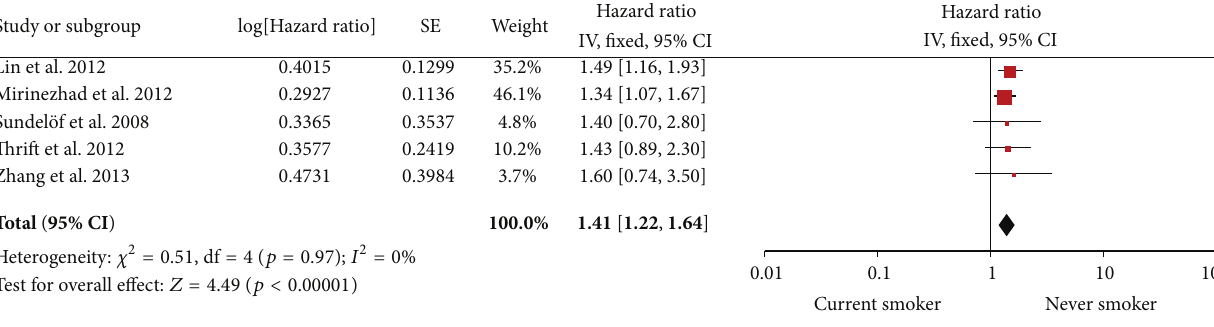
Figure 2: Current smoker versus never